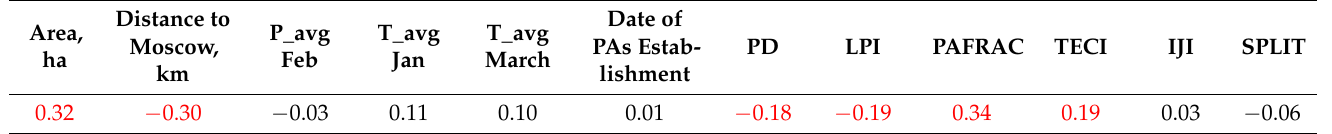
Table 6. Correlations of spatial and temporal factors with the typological diversity of PAs.